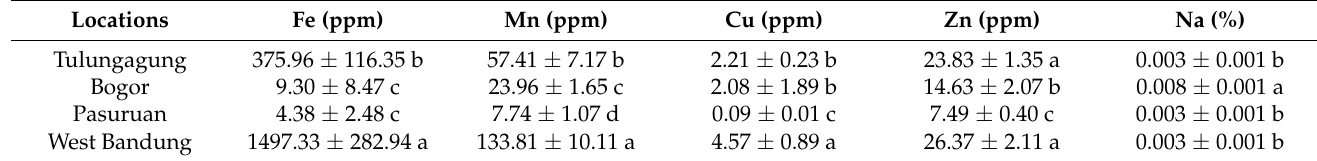
Table 8. Micronutrient status of kaffir lime leaves grown in four